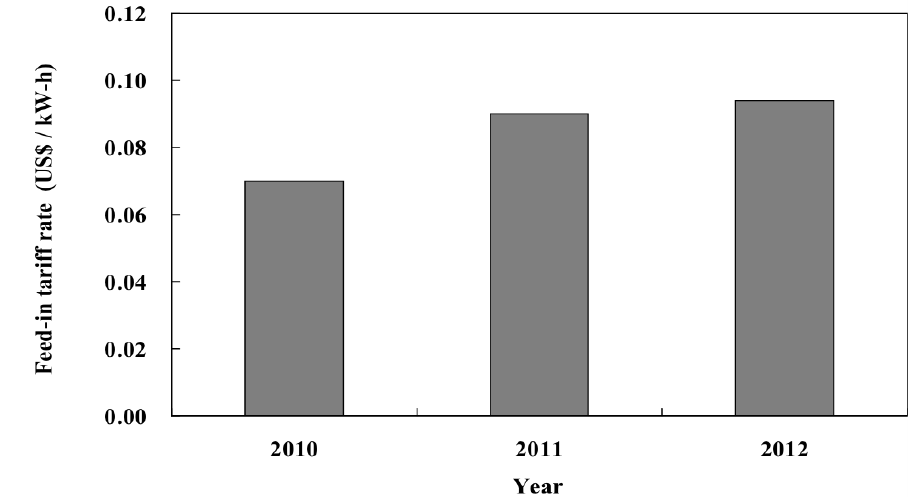
Figure 3. Variations of feed-in tariff rate for waste-to-energy (renewable power) in